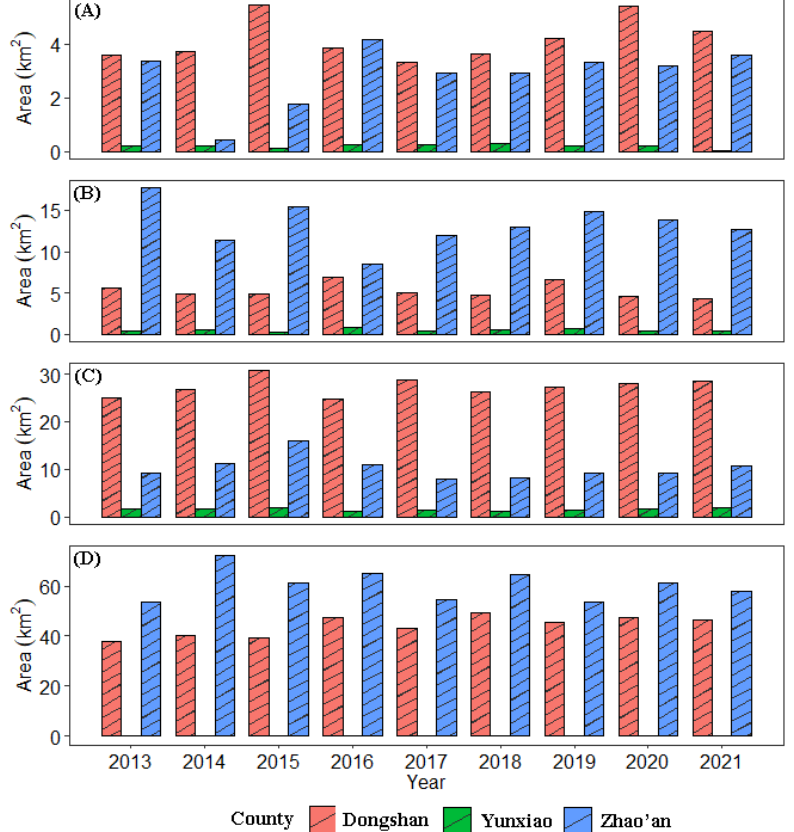
Figure 6. Plot showing changes in types of mariculture in different counties during the period from 2013 to 2021 including the ( A ) CM, ( B ) MM, ( C ) PM, and ( D ) RM. In Figure 7, inter-annual variations of different types of mariculture are displayed.